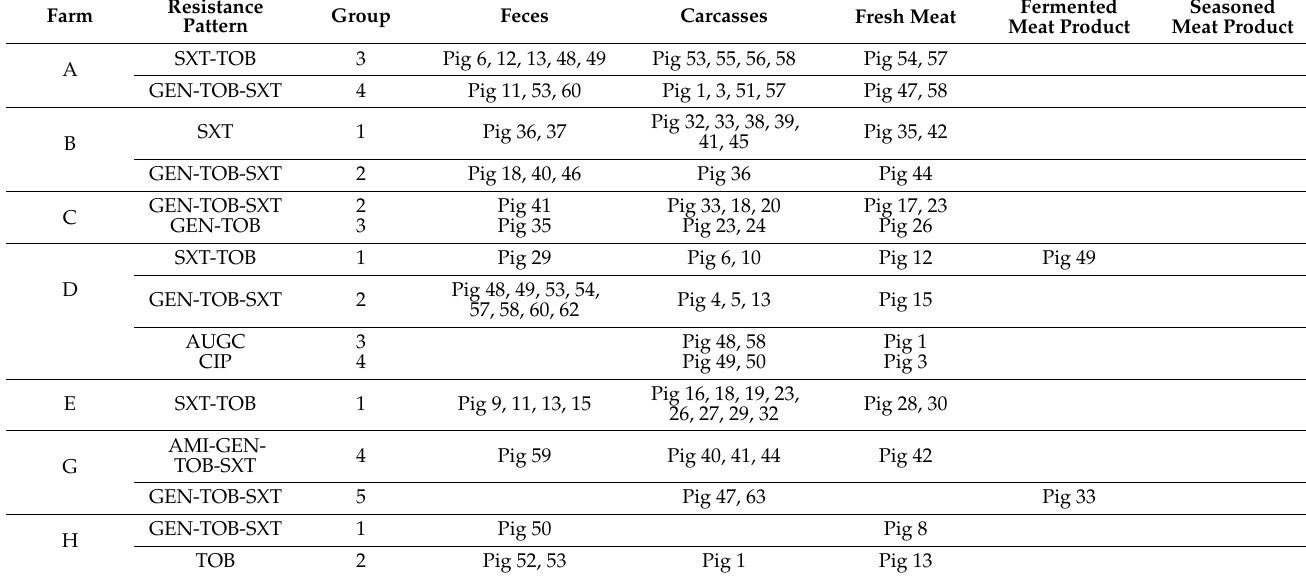
Table 2. E. coli AMR pattern detected in groups of pigs along the different food chains. The enumera- tion of “Pig” is independent and related to each